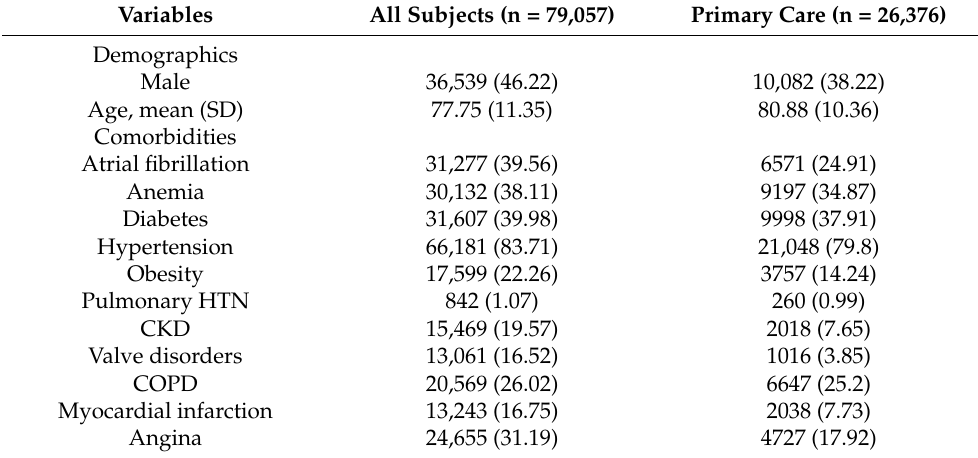
Table 4. Demographics and chronic diseases of the Heart Failure population